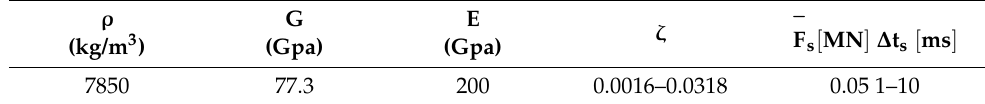
Table 2. Material properties of the tulip and shock